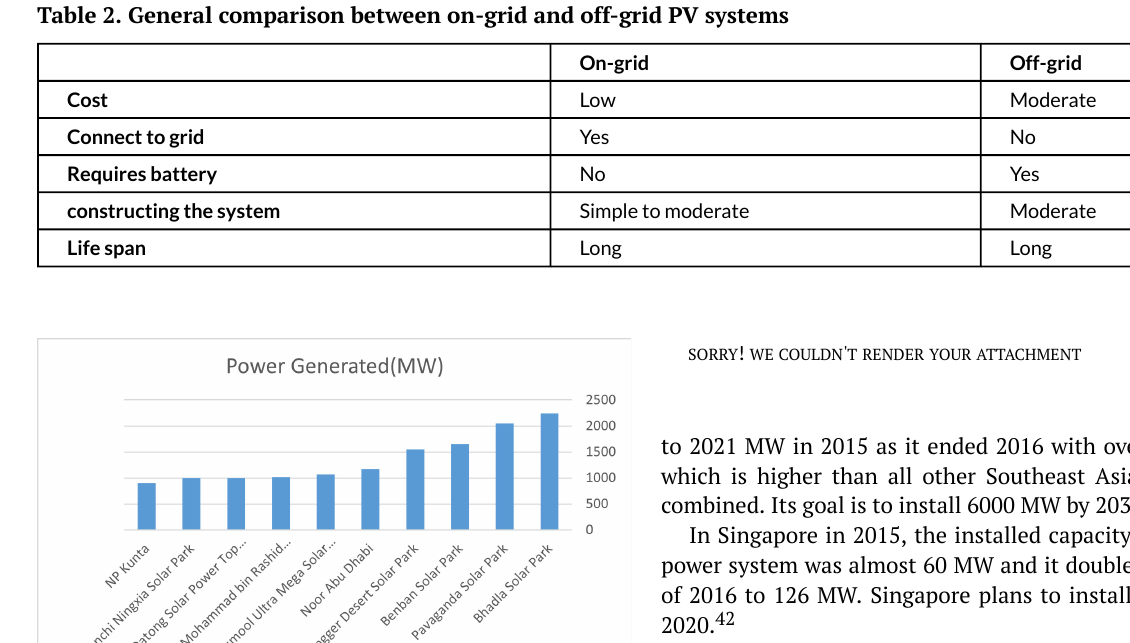
around 2.6 GW as of the end of August 2020. Although still considered a niche, FPV is expected to develop at a rate of more than 20% per year over the next five years. Asia is pre- dicted to represent nearly two-thirds of worldwide demand, with China, India, South Korea, Taiwan, Thailand, and Viet- nam leading the way.